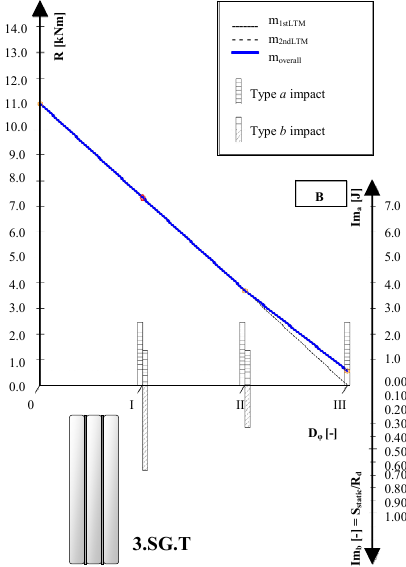
Figure 14: Element Safety Diagram for triple layer, SG-laminated, thermally tempered glass